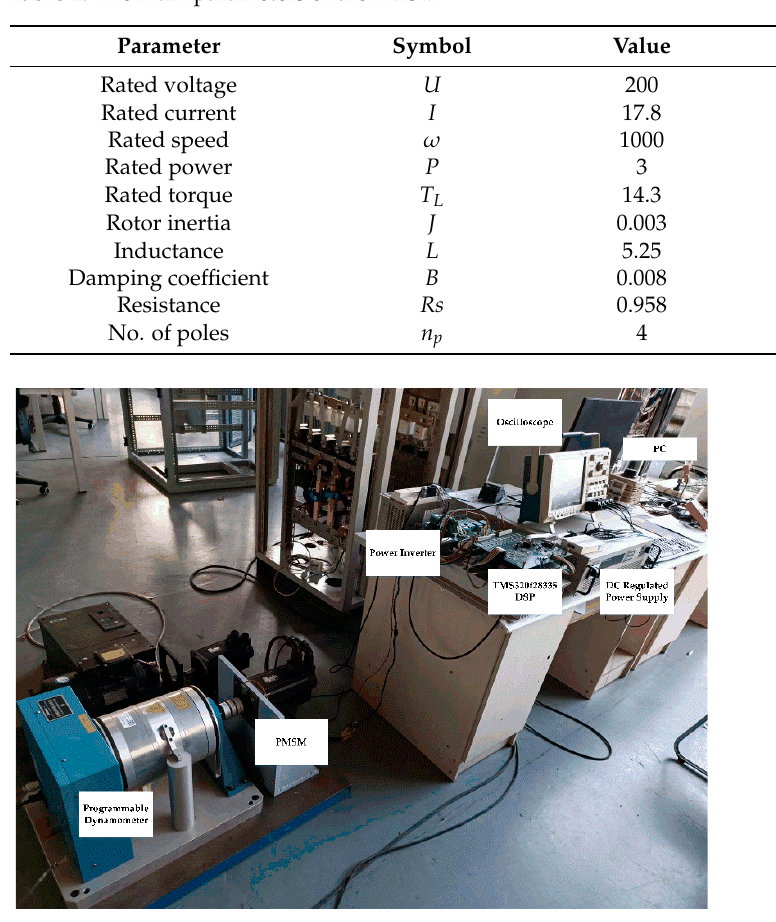
Figure 2. The experimental test platform.